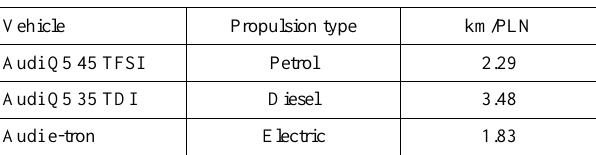
Table 17. Costs comparison segment SUV